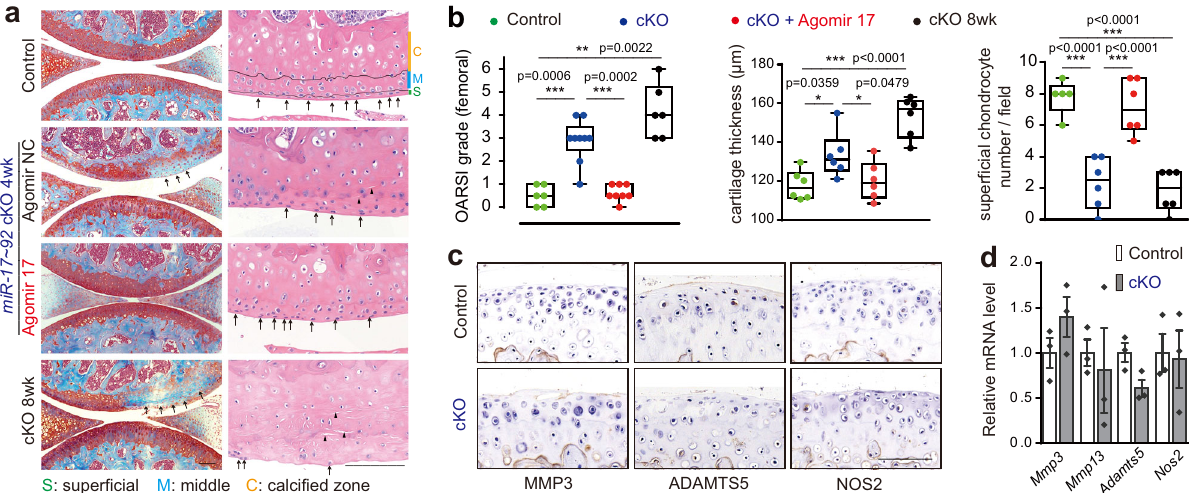
Fig. 4 Cartilage degeneration was developed in miR-17~92 cKO mice. a , b Safranin O/fast green staining and H&E staining of knee joint cartilage ( a ), OARSI grade ( n = 6 mice in control and cKO 8wk; n = 9 mice in cKO; n = 8 mice in cKO + agomir-17), cartilage thickness ( n = 6 mice per group) and cell counts of super fi cial chondrocytes ( n = 5 mice in control; n = 6 mice for other groups) in femoral condylar cartilage ( b ) from miR-17~92 fl / fl (control), miR- 17~92 cKO and agomir-17-injected cKO mice at 4 or 8 weeks after tamoxifen injection, were presented. The arrows in ( a ) indicated cartilage degeneration (left panels) and super fi cial chondrocytes (right panels). The triangles in ( a ) indicated splitting in cartilage matrix. c , d IHC staining of MMP13, ADAMTS5 and NOS2 ( c ), and qRT-PCR analysis of catabolic factors ( d ) in cartilage of control and miR-17~92 cKO mice at 4 weeks after tamoxifen injection. n = 4 mice per group in ( c ) and n = 3 mice per group in ( d ). Data were presented as boxplots (center line, median; box limits, 25 to 75th percentiles; whiskers, min to max), or the mean ± s.e.m. values. * P < 0.05, and *** P < 0.001. Mann – Whitney U test (two sided) for OARSI grade; one-way ANOVA with Bonferroni ’ s test for cartilage thickness and cell number; two-sided Student ’ s t test for qRT-PCR. All scale bars, 100 μ m. Exact P values in ( d ):